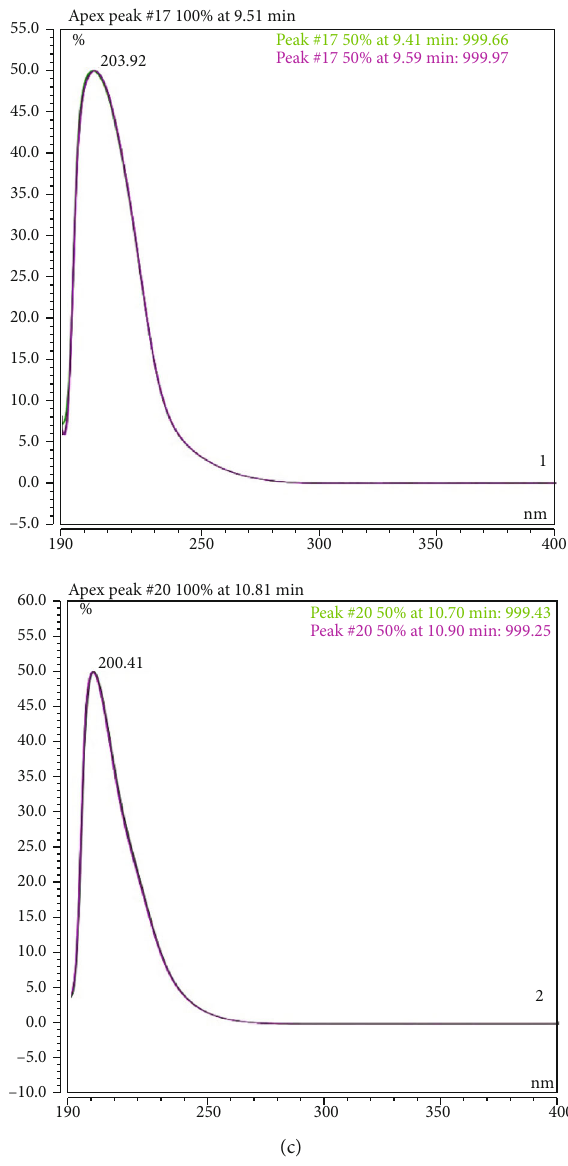
Figure 7: HPLC chromatograms ((a) 2D; (b) 3D) of two standard compounds from the ethanolic extract of SR at UV wavelengths of 200 nm (c). Costunolide (1) (9.39 min) and dehydrocostuslactone (2) (10.68 min) were identi fi ed. Table 3: Regression data and contents of two compounds in